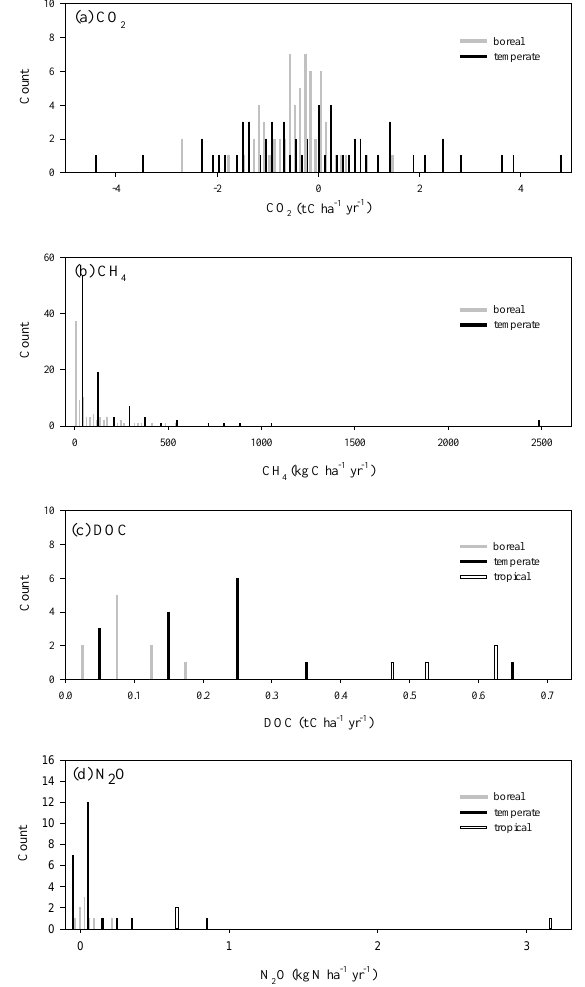
Figure 4. Frequency distributions of (a) carbon dioxide (CO 2 ; t C ha -1 yr -1 ), (b) methane (CH 4 ; kg C ha -1 yr -1 ), (c) dissolved organic carbon (DOC; t C ha -1 yr -1 ) and (d) nitrous oxide (N 2 O; kg N ha -1 yr -1 ) fluxes in undrained and rewetted organic soils in the boreal, temperate and tropical (DOC and N 2 O) climate zones. Negative values indicate annual removals and positive values indicate annual